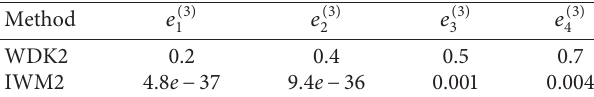
Table 4: Simultaneous finding of all roots.